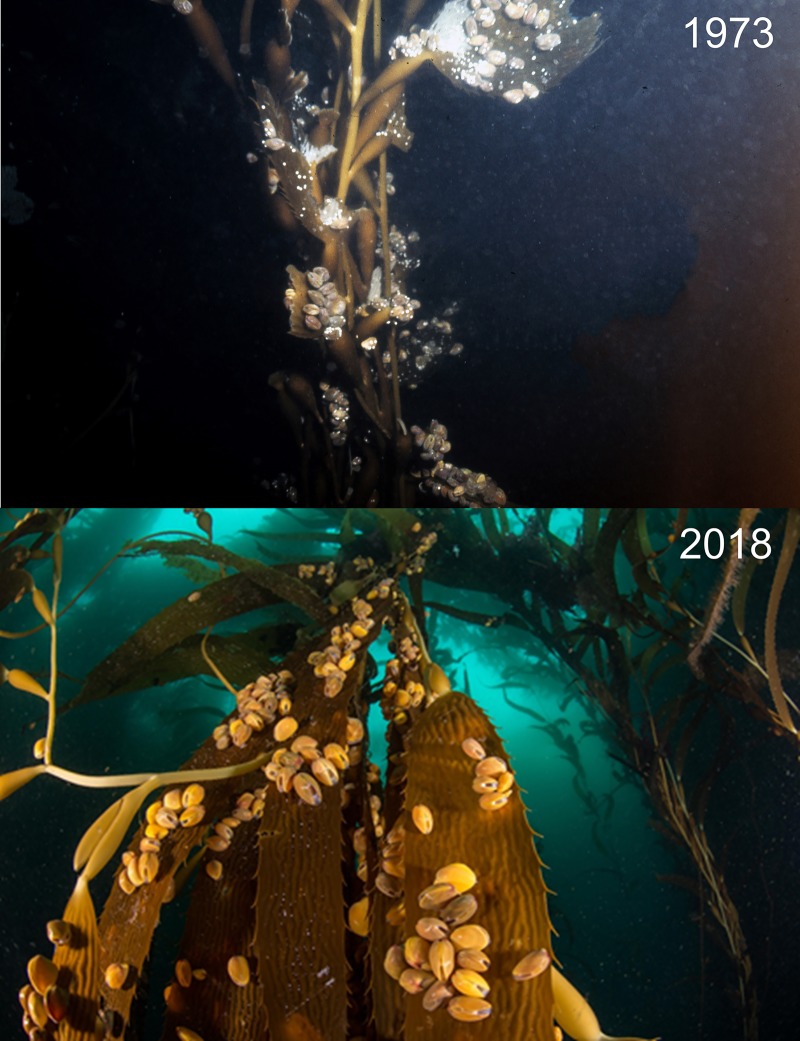
The bivalve mollusk Gaimardia trapesina growing on the fronds of Macrocystis pyrifera.